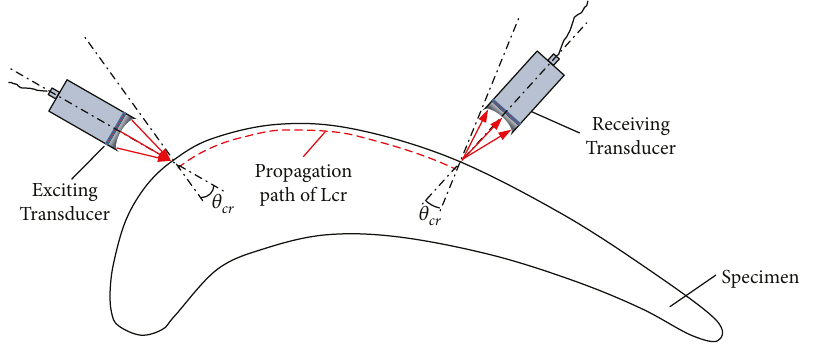
Figure 2: Critical refracted longitudinal waves propagating in a curved surface.